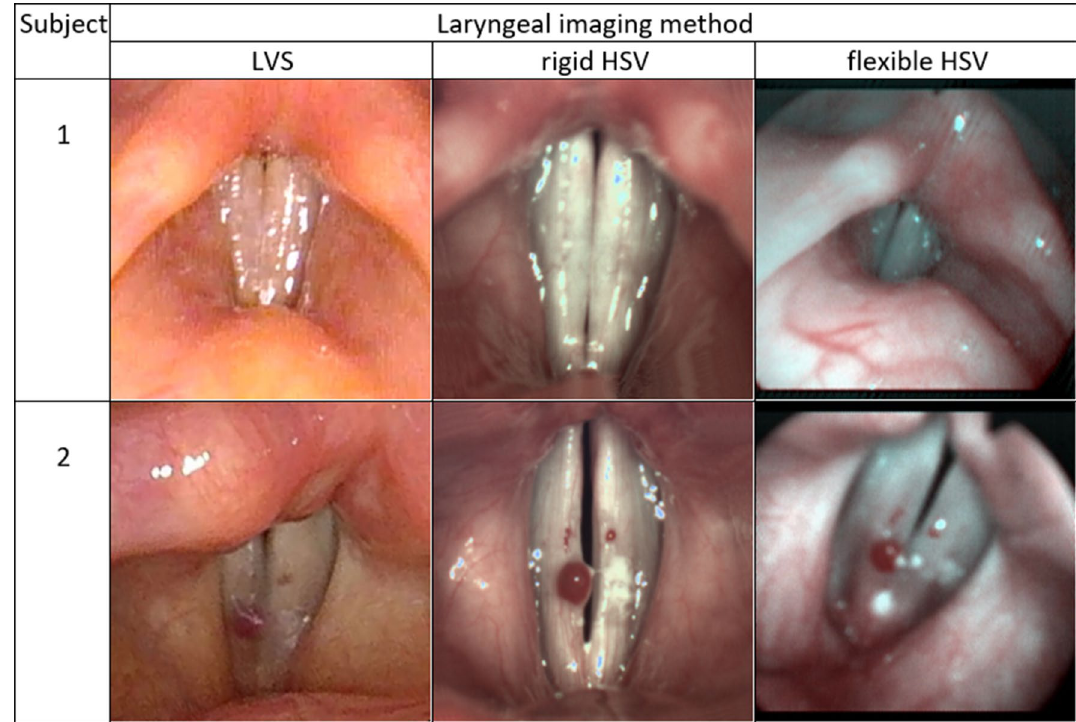
Figure 2. Comparison of glottal images for Subject 1 and Subject 2, obtained using three different methods. From left to right: Laryngovideostroboscopy (LVS); High Speed Videoendoscopy by means of rigid optics (rigid HSV); High Speed Videoendoscopy by means of flexible optics (flexible HSV).